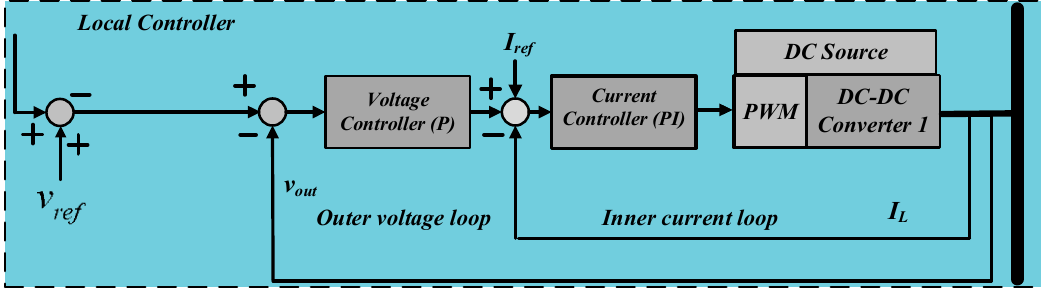
Figure 2. Local controller of the existing technique [13].